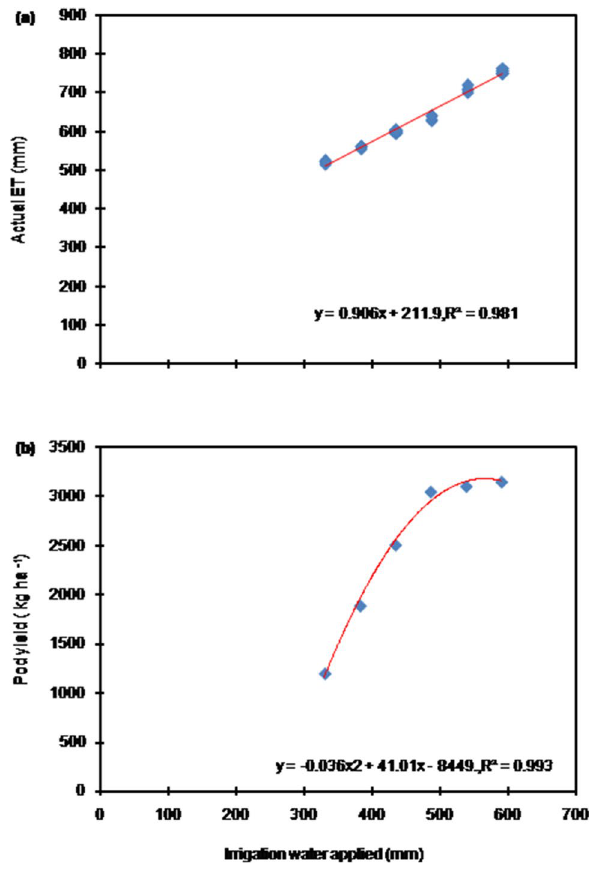
Figure 1. Relationship between irrigation water applied and AET ( a ) and AET and pod yield ( b ) of peanut during 2012–2014 at Bikaner, India. Each data point is average of 36 values. AET : actual crop